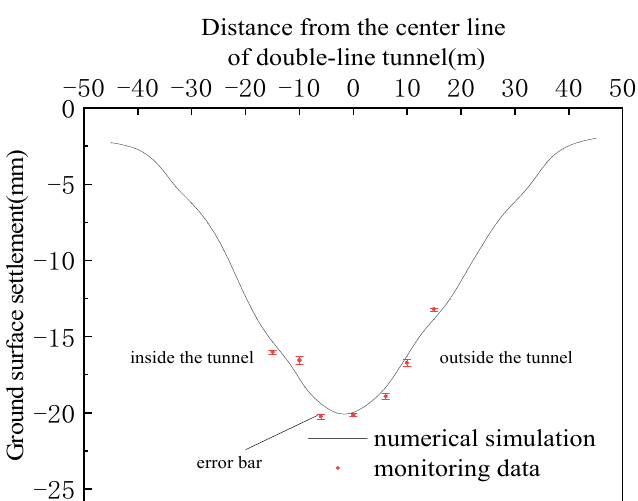
Figure 5. Layout of monitoring points.